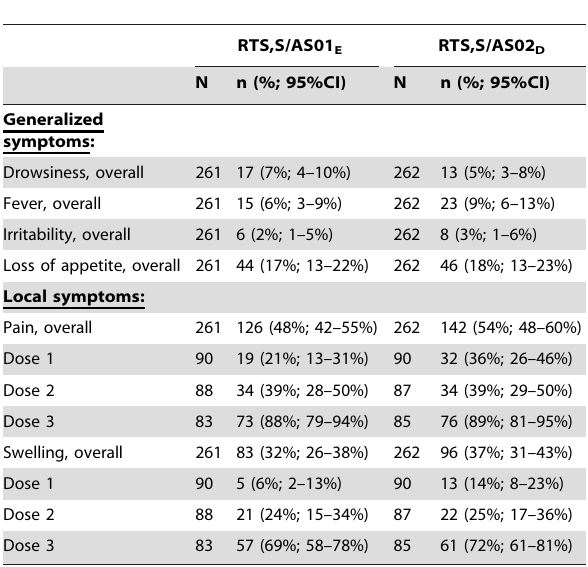
Table 2. Solicited symptoms per dose during a 7-days post- vaccination period.